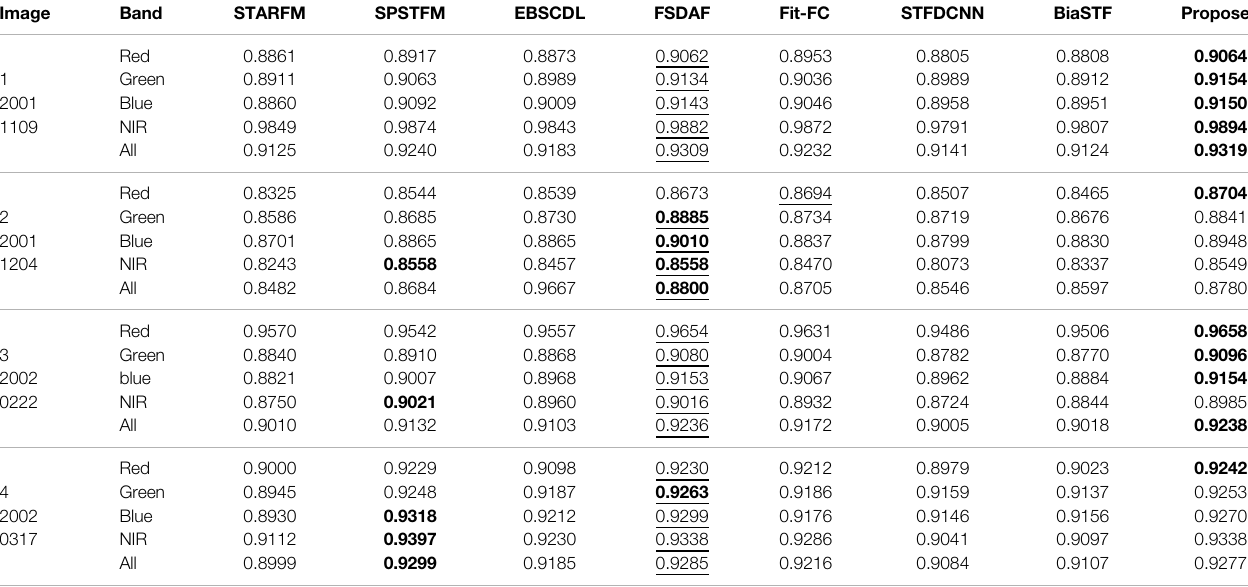
TABLE 4 | SSIM evaluation of structural discrepancy for the CIA dataset.